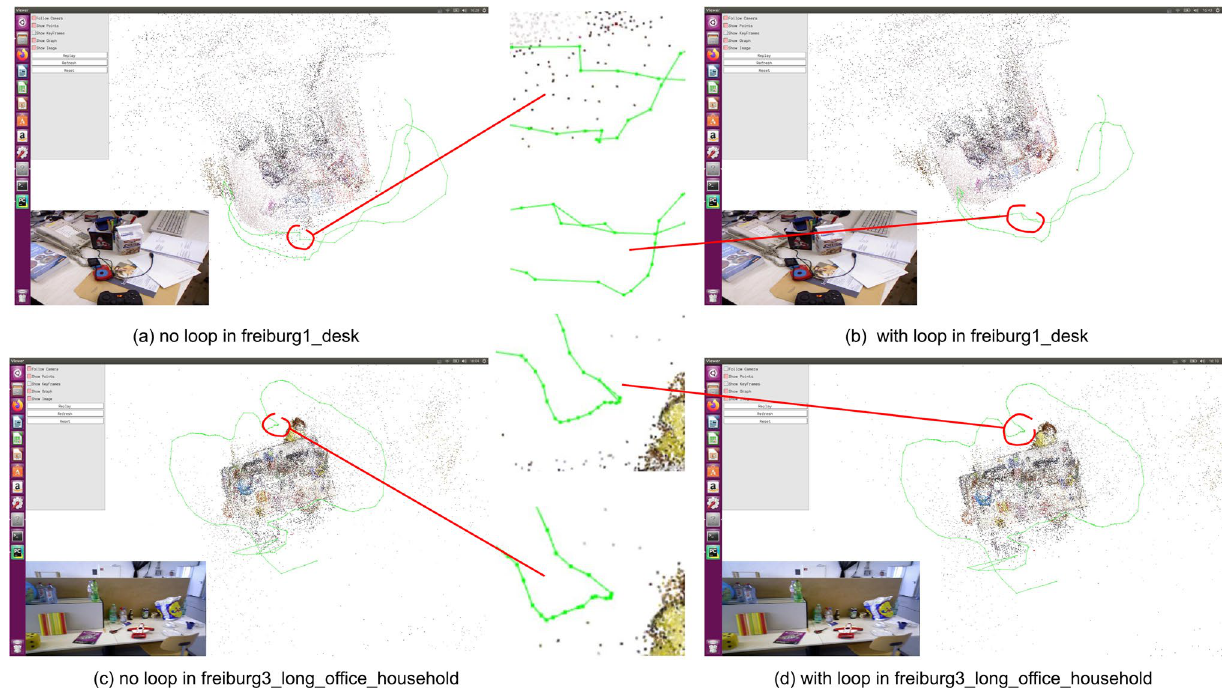
Fig. 11 In this image using loop closure detection based on ECMobileNet work